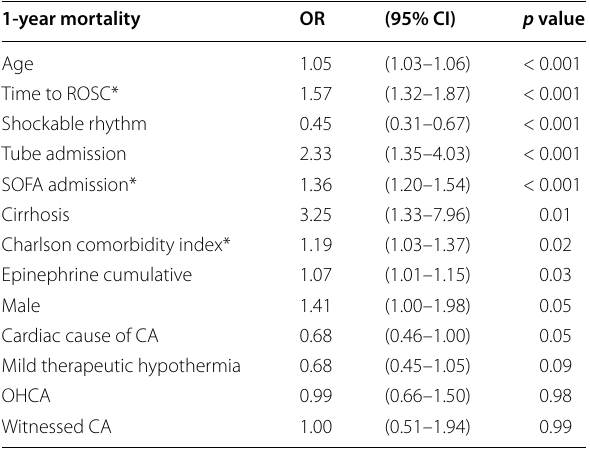
Table 4 Logistic regression model for factors associated with 1-year mortality